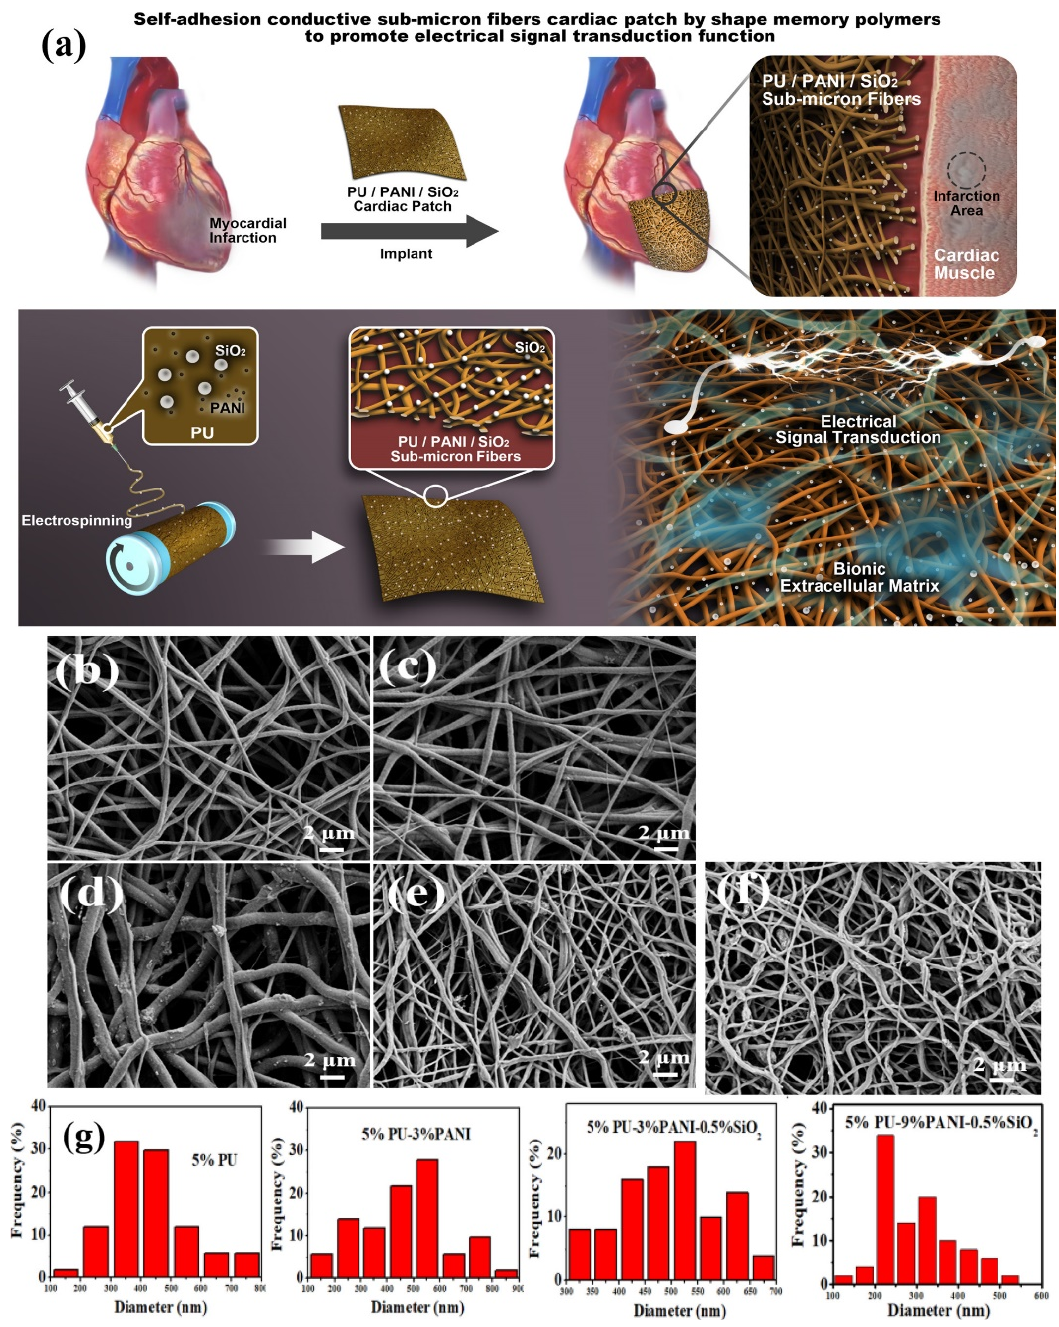
Figure 16. ( a ) Fabrication and self-adhesion of sub-micron fiber cardiac patch. SEM of ( b ) 5% PU, ( c ) 5% PU–3% PANI, and ( d ) 5% PU–3% PANI–0.5% SiO 2 , ( e ) 5% PU–6% PANI–0.5% SiO 2 , and ( f ) 5% PU–9% PANI–0.5% SiO 2 , and ( g ) fiber diameter distribution. Reprinted (adapted) with permission from [161]. Copyright 2021 American Chemical